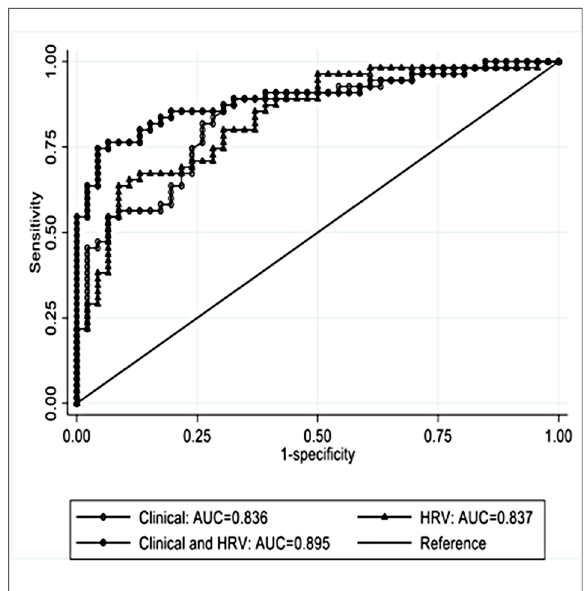
FIGURE 1 The AUROC of the multivariable analysis for HRV and clinical prediction model.